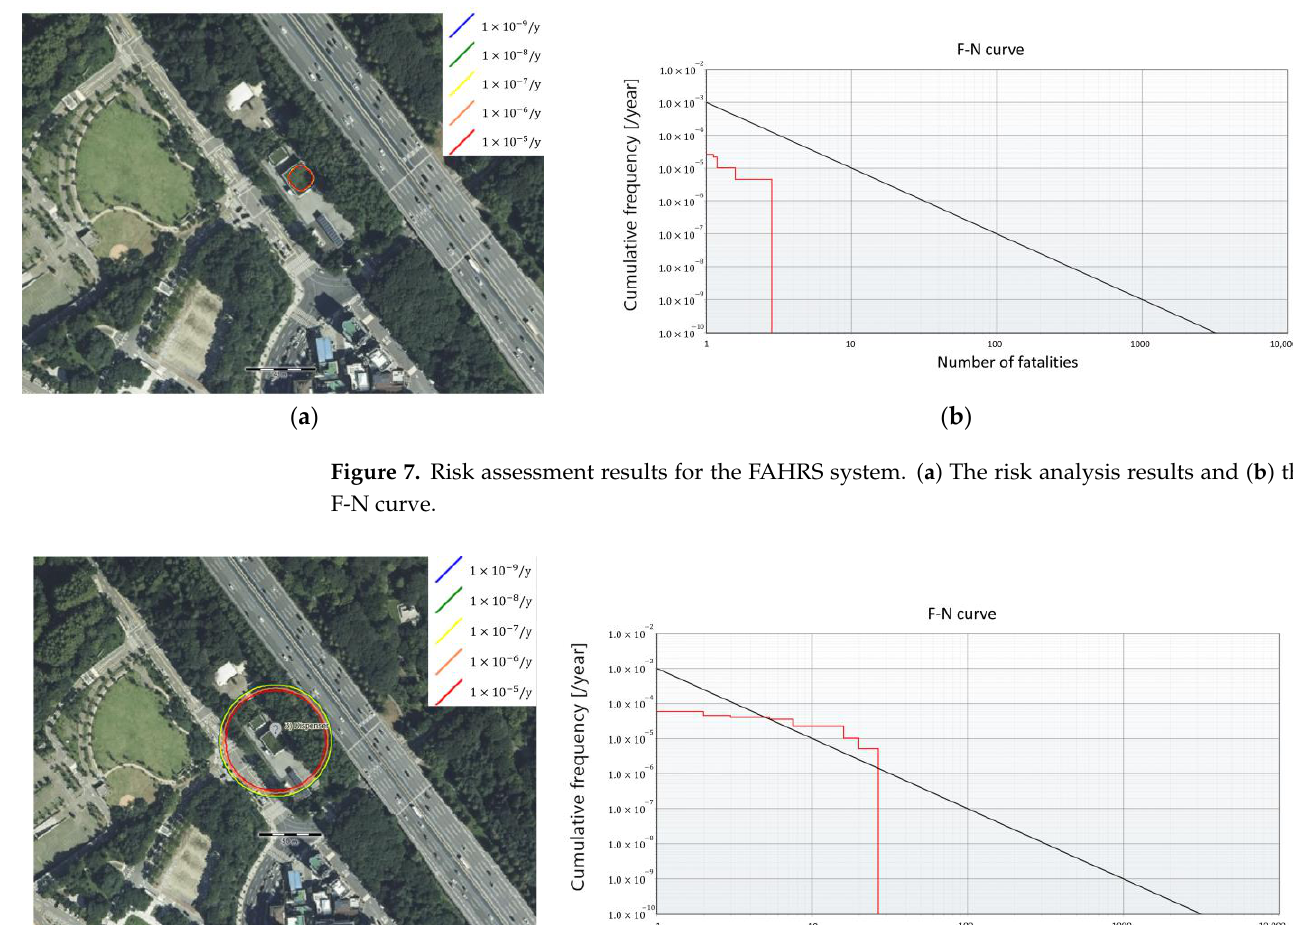
Table 5. The societal risk values with respect to the scenarios for the FAHRS system.